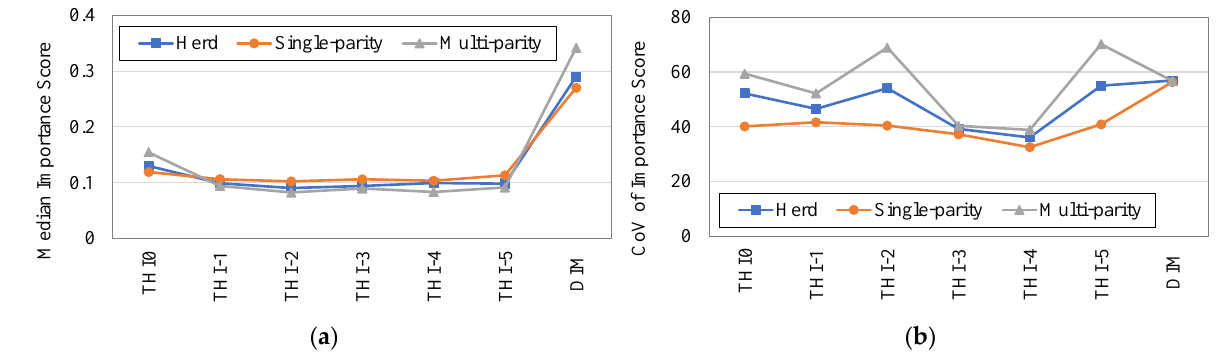
Figure 9. Disaggregation of the IS values between single-parity and multiparity cows. ( a ) Median value of each IS; ( b ) CoV value of each IS.